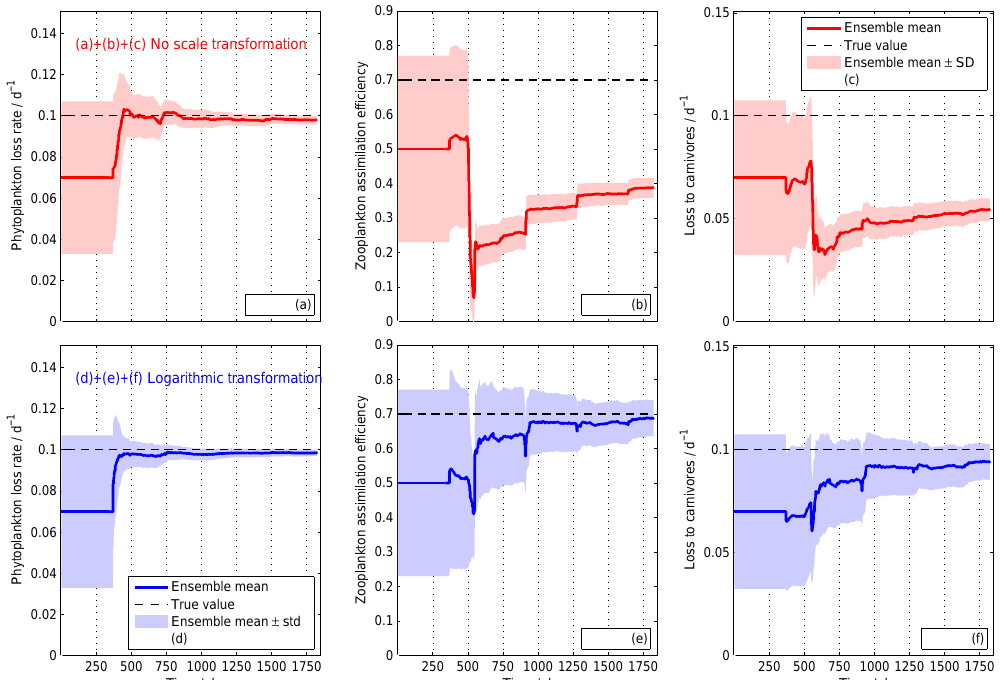
Figure 1. Time evolution of parameter estimates in a simulation test of an ensemble Kalman filter using untransformed data ( a–c , top row panels) and using logarithmic transformed data ( d–f , bottom row panels) (Simon and Bertino, 2012, Fig. 3). Solid lines and shading show ensemble means and standard deviations averaged over 20 simulation experiments, while dashed lines show the true parameter values. The data were generated using Gamma-distributed observational errors with standard deviation ∼ 30% (see Simon and Bertino, 2012). A transformation can significantly reduce the bias of parameter estimates by the end of the assimilation period. Figure was redrawn from results provided by Ehouarn Simon, with permission from Elsevier. Copyright of figure content by